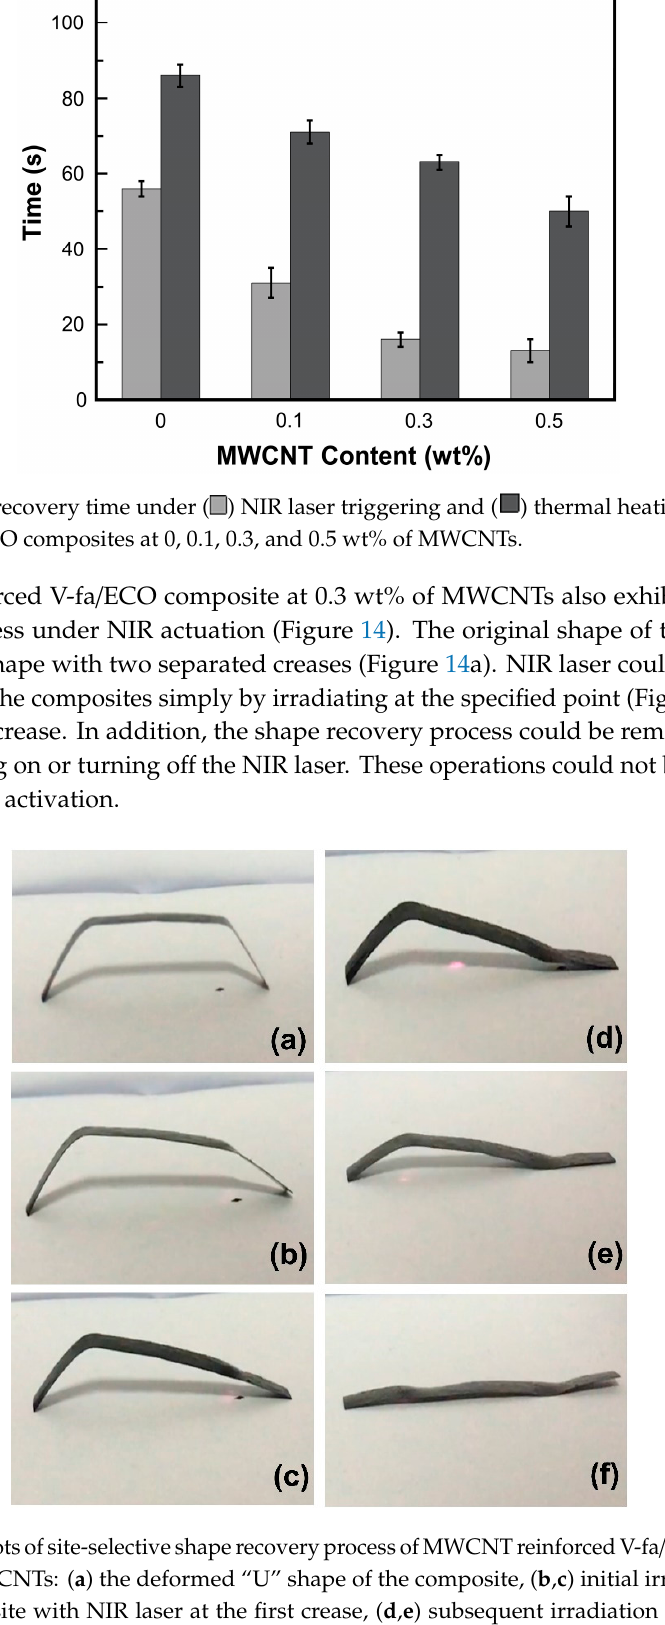
Figure 12. Snapshots of shape recovery process of MWCNT reinforced V-fa/ECO composite at 0.3